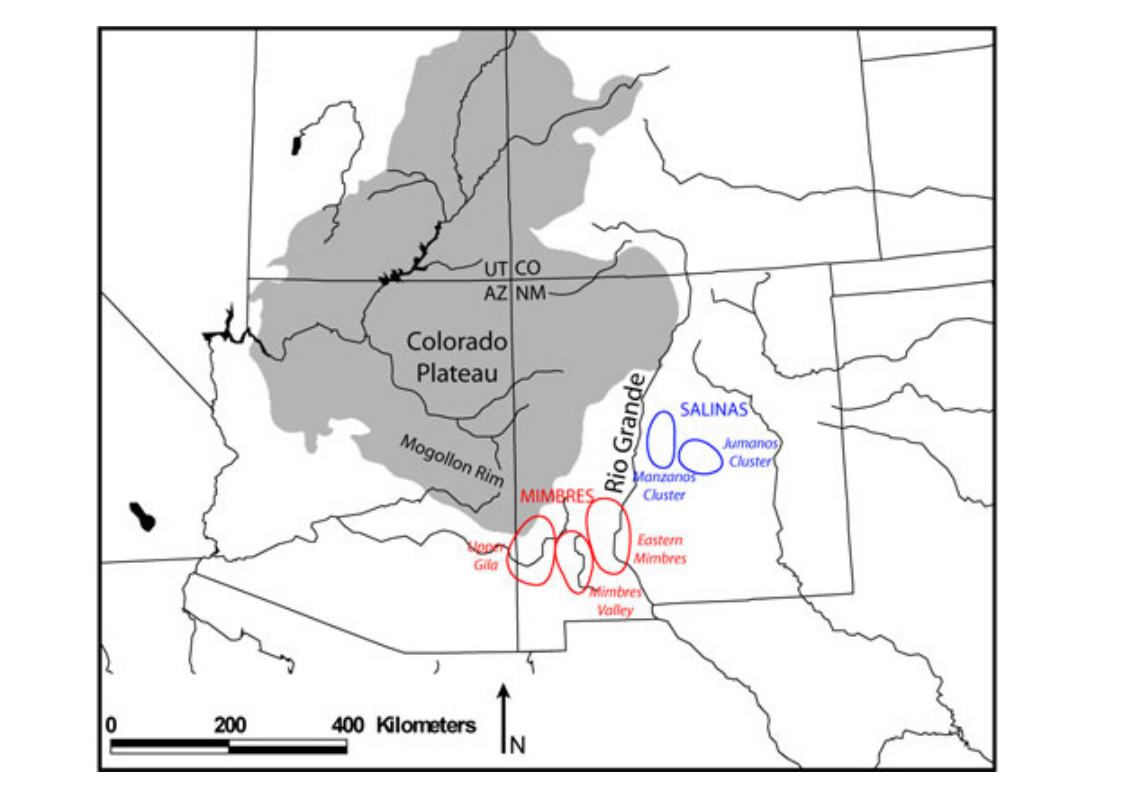
Fig. 1 . Map of the